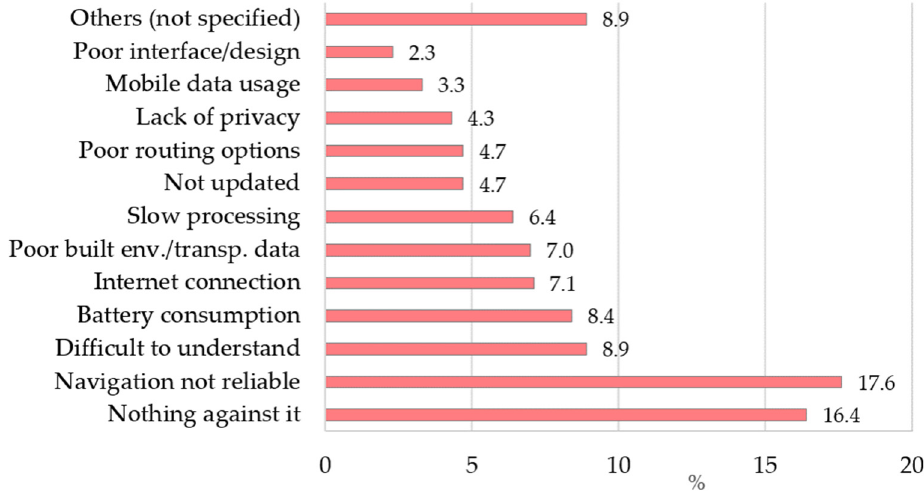
Figure 5. What people like the least in their pedestrian navigation